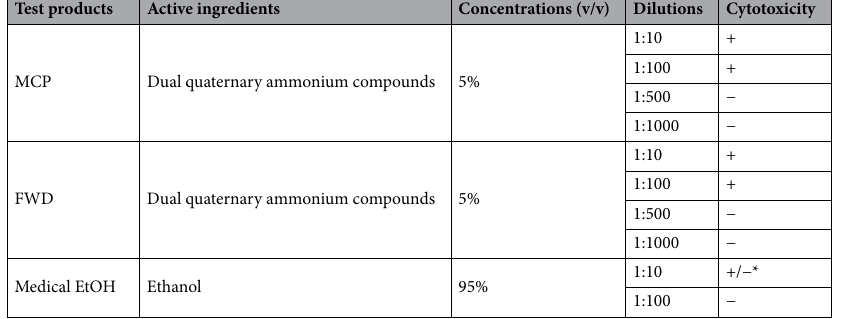
Table 1. Tested disinfectants and the cell sensitivity to the disinfectants. “+” means cytotoxicity; “−” means no cytotoxicity. *A slight cytotoxic effect caused by medical ethanol was observed, but it disappeared after the treatment was removed and cells were refed with fresh DMEM with 2% FBS medium